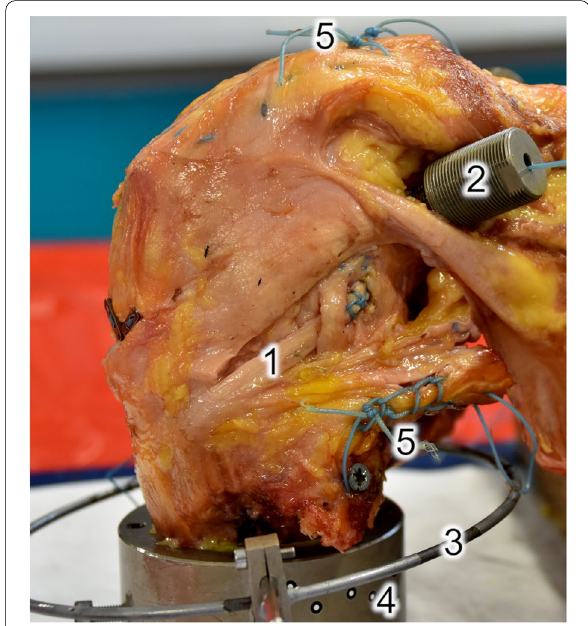
Fig. 1 Specimen preparation: 1, lateral extra-articular tenodesis using the modified Lemaire technique with a 10 mm wide strip of the iliotibial band shuttled deep to the lateral collateral ligament and fixed at 60° of flexion with 20 N [23]; 2, cortically fixed part of the custom graft force measuring device (in line with femoral graft tunnels); 3, fixture for applying anterior tibial translation forces, including a tibial ring; 4, embedding mould with optical markers to evaluate knee joint motion; 5, armed muscle tendons (quadriceps and hamstring) for active dynamic preconditioning cycling